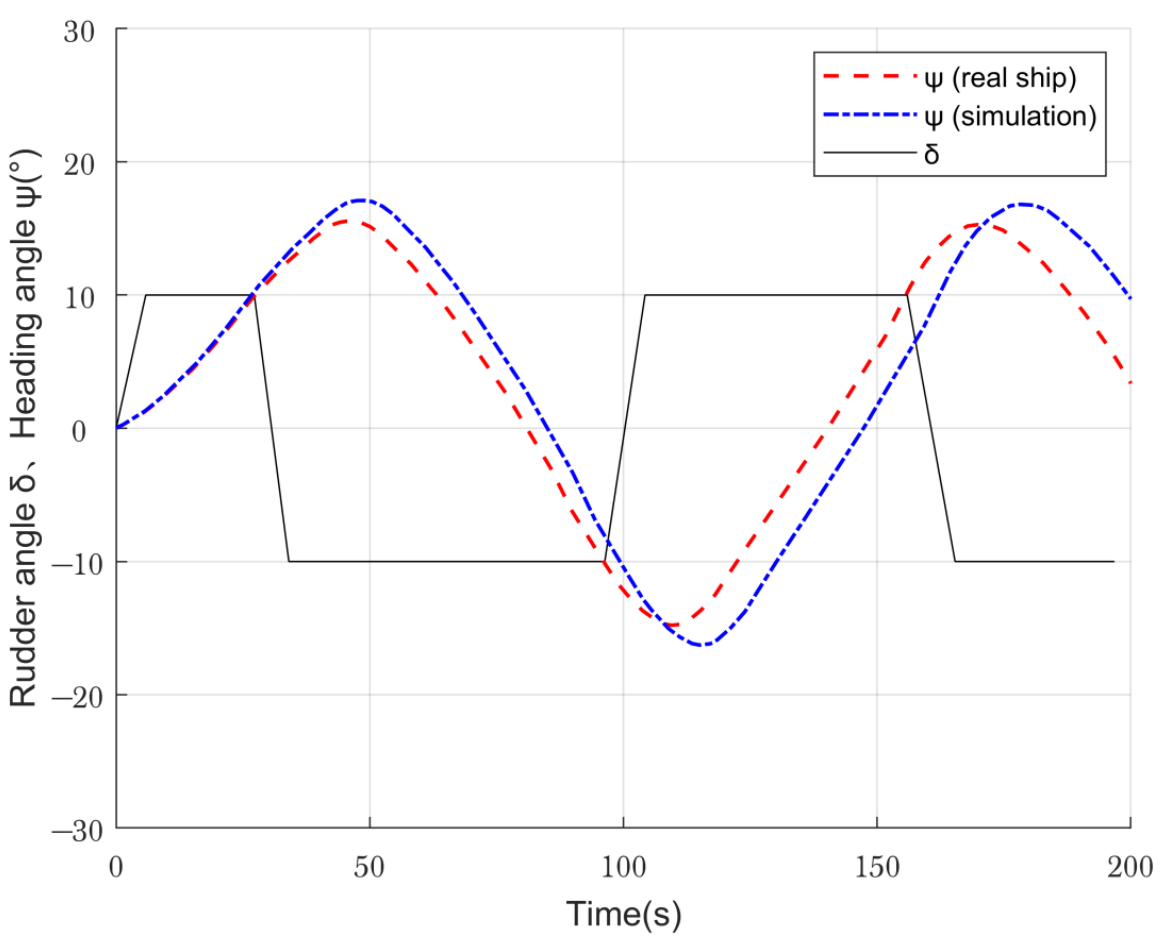
Figure 7. Right 10°/10° Z-type maneuver test. Figure 7. Right 10 ◦ /10 ◦ Z-type maneuver